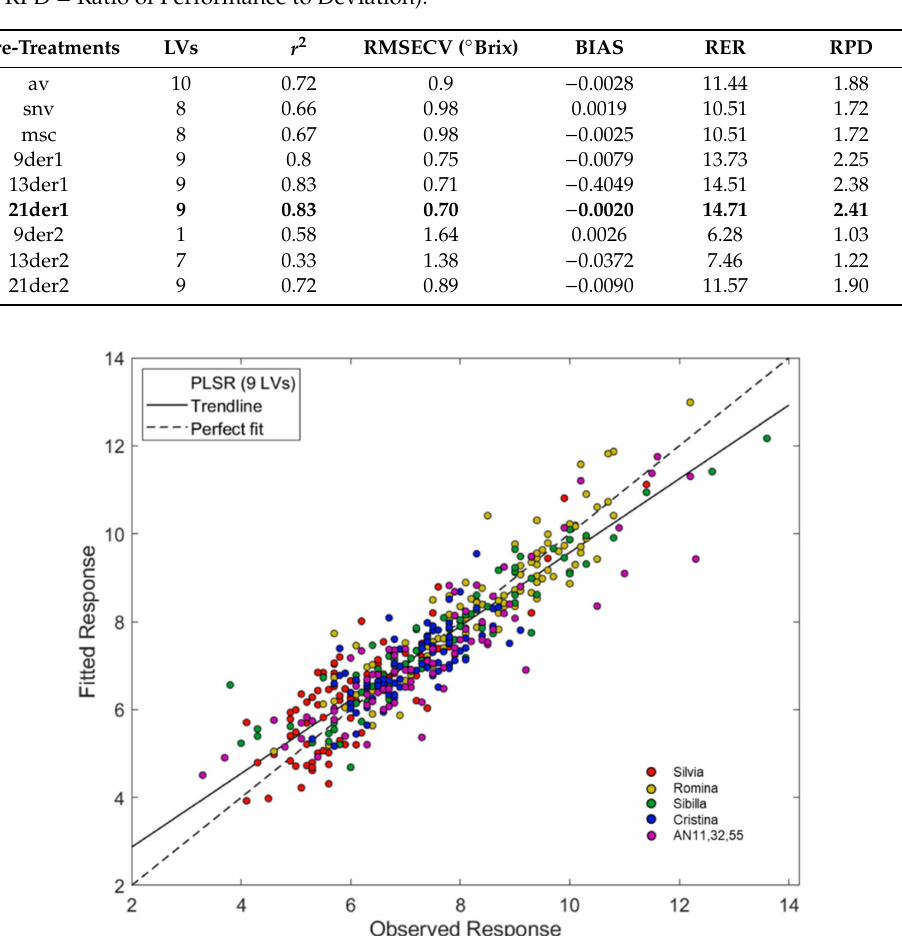
Figure 4. Regression plot of the Partial Least Squares Regression (PLS) model for the prediction of the soluble solids content obtained with Near Infrared (NIR) spectra pretreated with first derivatives (Savitzky–Golay filter, 21 smoothing points, 2nd polynomial